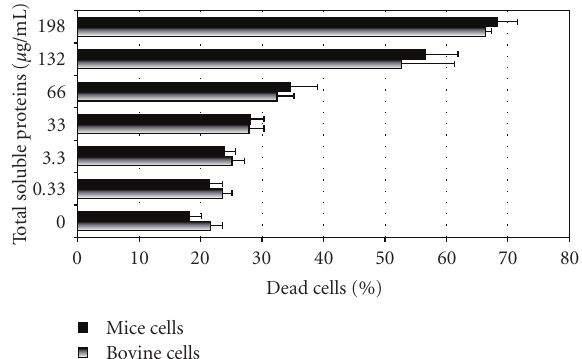
Figure 5: Assessment of the cytotoxicity of tobacco leaf extracts (TLEs) from nongenetically modified tobacco plants on mouse and bovine cells. TLE was added to mouse spleen cells and to bovine PBMC (2 × 10 6 cells/mL) with final dilutions ranging from 0.01% to 6% (v/v). The concentration of total soluble proteins (TSPs) in the TLE dilutions was determined by the Bradford assay. The percentage of dead cells was measured 4 days later by flow cytometry after propidium iodide labeling (2 μ L). The histogram presents the mean percentage ( ± SD) of dead cells ( X -axis) induced by each TSP concentration ( Y -axis) for each animal cell